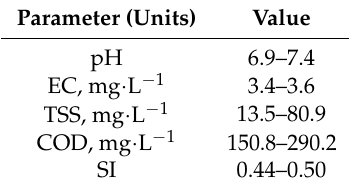
Table 3. Key physicochemical characteristics of the feedstream